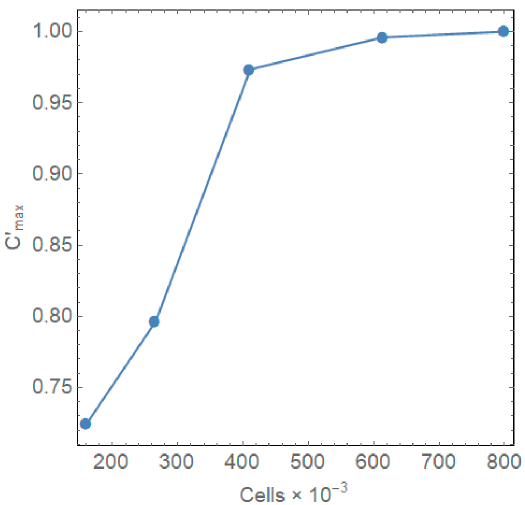
Figure 2. Dependence of the maximum concentration on the domain symmetry surface on the number of cells.